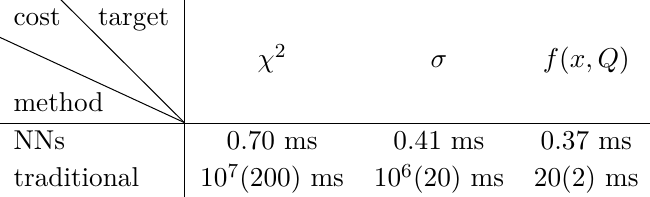
Table 5 . Comparison on computational cost between NNs and traditional methods. Numbers in parenthesis represent cases if fast interpolations on PDFs are